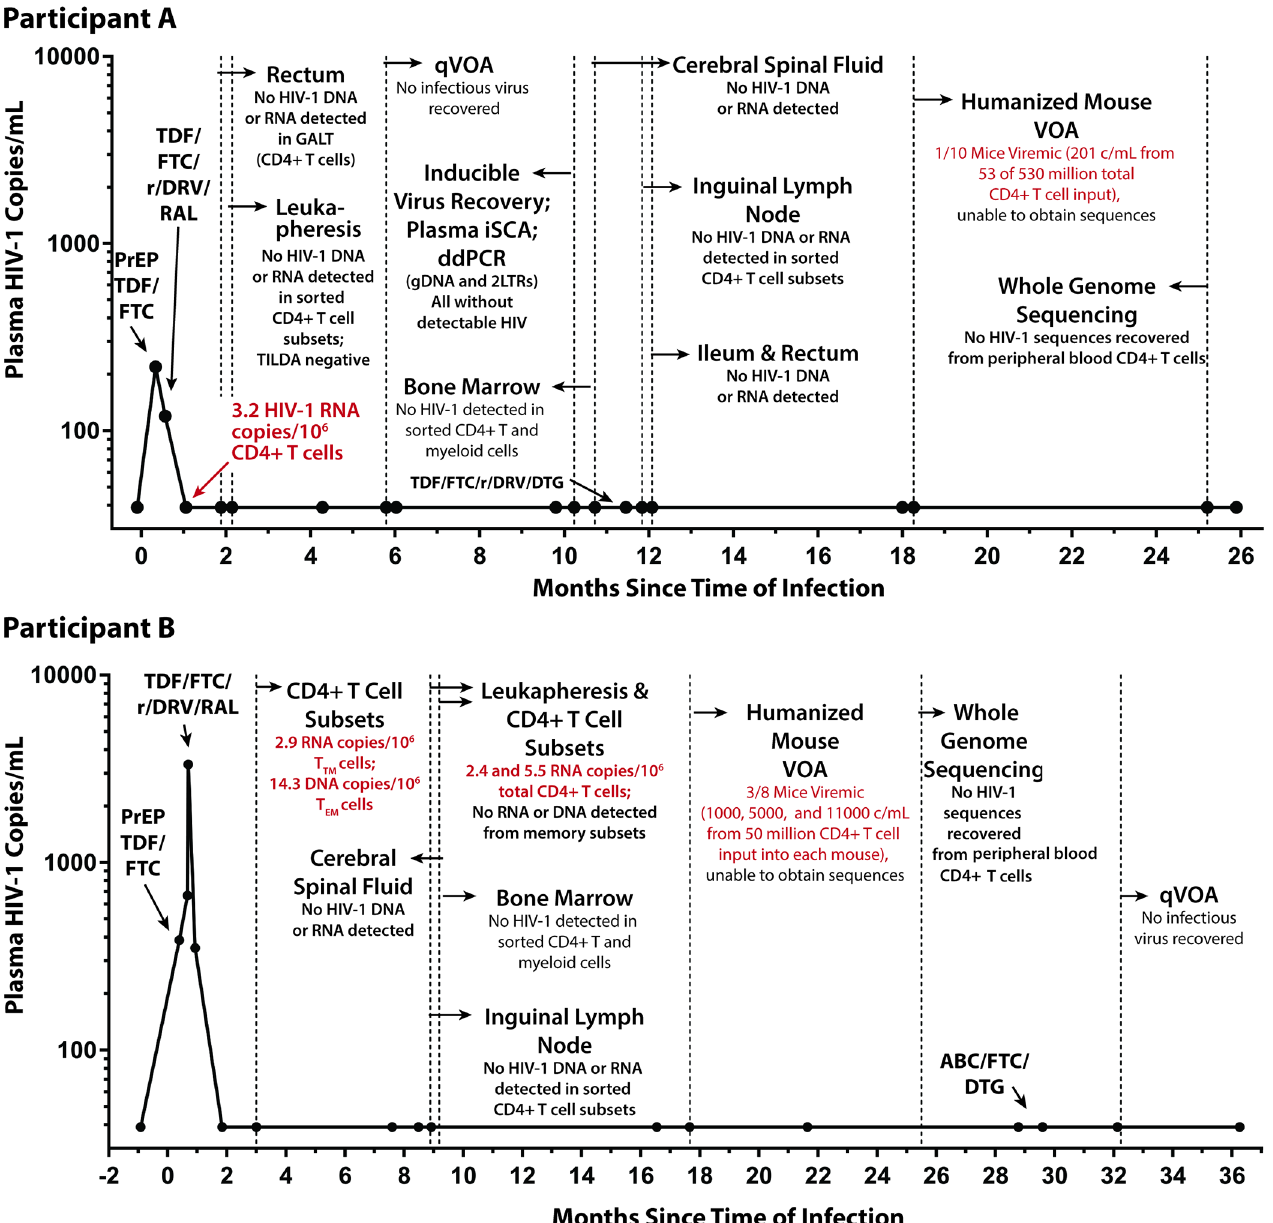
Fig 1. Extremely early ART reduces HIV reservoirseeding. No HIV was detected in colorectal and lymph node tissues, bone marrow, CSF, plasma, and very large numbers of PBMCs obtainedlongitudinally from ParticipantA (top panel)who started PrEP 10 days followingHIV infection. In contrast, low-levelHIV RNA and DNA were intermittently detected in PBMCs from ParticipantB (bottom panel)who initiatedPrEP 12 days followinginfection prior to starting a 4-drug ART regimen. One of 10 humanizedmice given 53 million input cells from ParticipantA developedlow- level HIV RNA in plasma (201 copies/mL), but sequencing of HIV from plasma was unsuccessful. Abbreviations: ABC, abacavir;CSF, cerebral spinal fluid; ddPCR, droplet digital PCR; DTG, dolutegravir; FTC, emtricitabine; GALT, gut-associated lymphoidtissue; iSCA, HIV integrase single copy plasma RNA assay; PBMC, peripheral blood mononuclear cell; PrEP, pre-exposure prophylaxis; qVOA, quantitative viral outgrowthassay; RAL, raltegravir;r/DRV, ritonavir-boosted darunavir;TDF, tenofovir; TILDA, Tat/Rev InducedLimitingDilution Assay; VOA, viral outgrowth